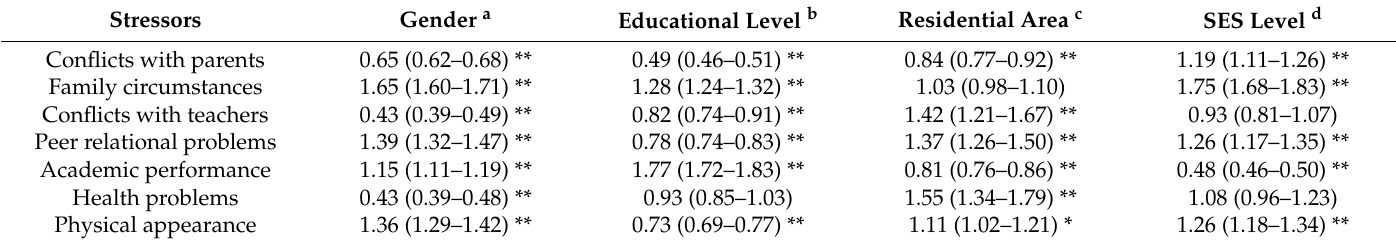
Table 3. Differences in major stressors among Korean adolescents according to gender, educational level, residential area, and SES level.